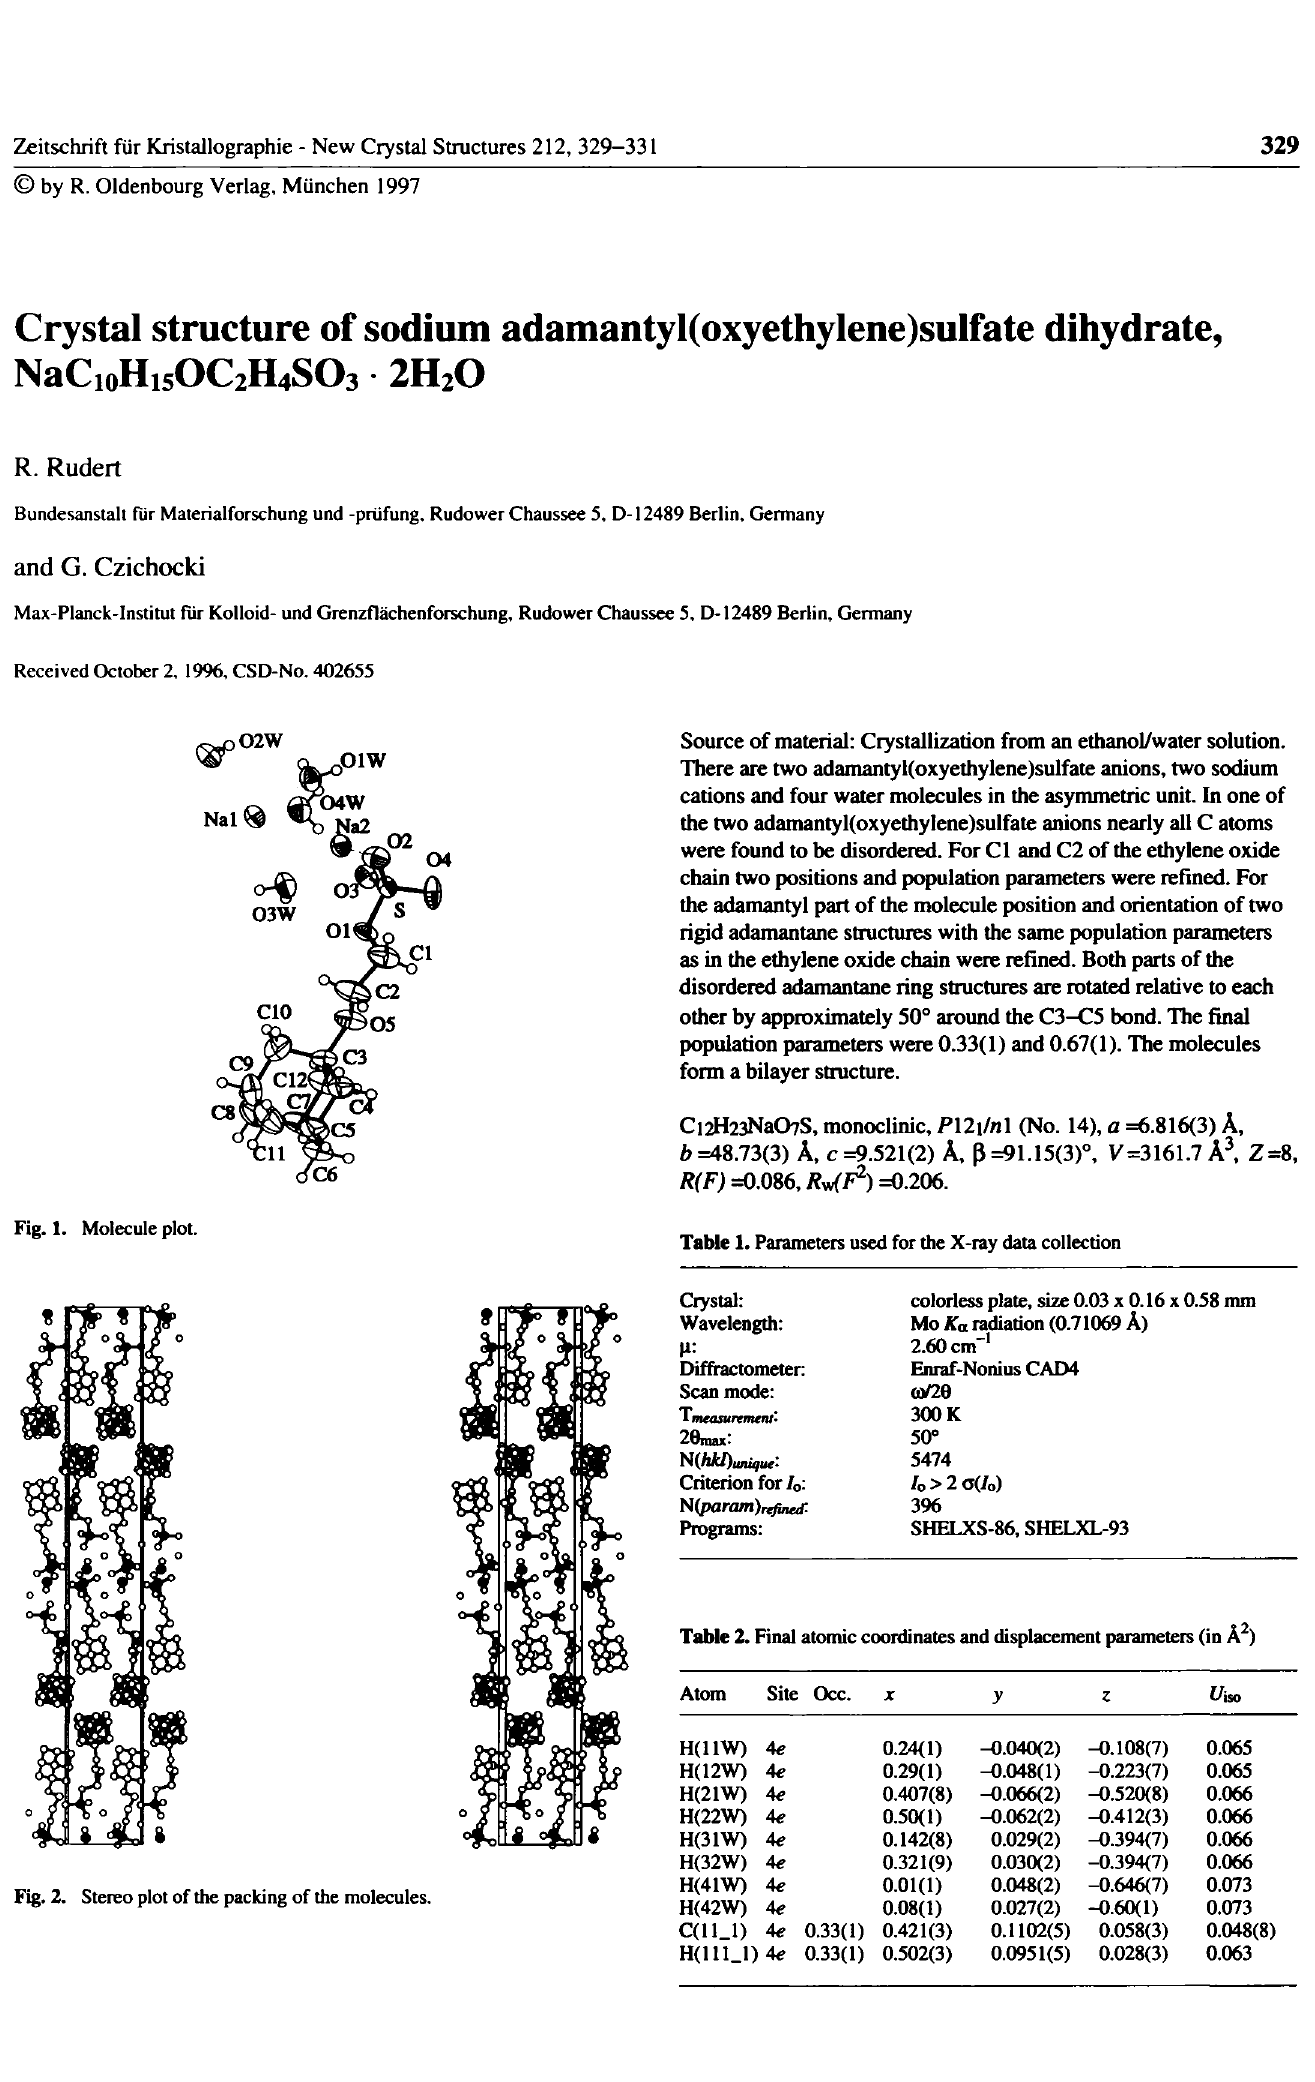
Table 2. Final atomic coordinates and displacement parameters (in Â 2 ) Atom Site